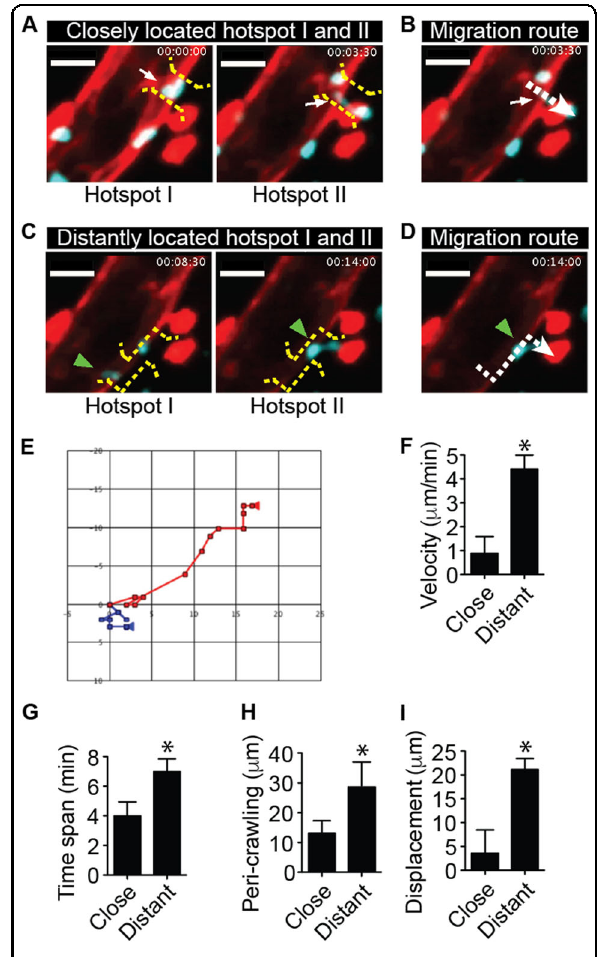
Fig. 6 The distance between hotspots I and II determines the perivascular crawling pattern upon stimulation with N - formylmethionyl-leucyl-phenylalanine. a The neutrophil quickly penetrated the vascular endothelium through closely located hotspots I and II. The white arrow indicates a hotpot, which is located between the yellow dotted brackets. b The migration route of the neutrophil through the closely located hotspots I and II is indicated by the white dotted arrow. c The neutrophil spent considerable time in the endothelial basement membrane when using the route of distantly located hotspots I and II. The green arrowhead indicates a hotpot between the yellow dotted brackets. d The migration route of the neutrophil through the distantly located hotspots I and II is indicated by the green arrowhead. a – d were generated from Video 12. Scale bar, 20 μ m. e The migratory patterns of neutrophils using the quick route and round route during extravasation were compared in rectangular coordinates. Unit; μ m. Velocity ( f ), time span ( g ), perivascular crawling distance ( h ), and displacement ( i ) were compared between fast penetrating and round penetrating neutrophils. * P < 0.005. A representative dataset from >10 extravasating neutrophils from 3 independent intravital imaging experiments is